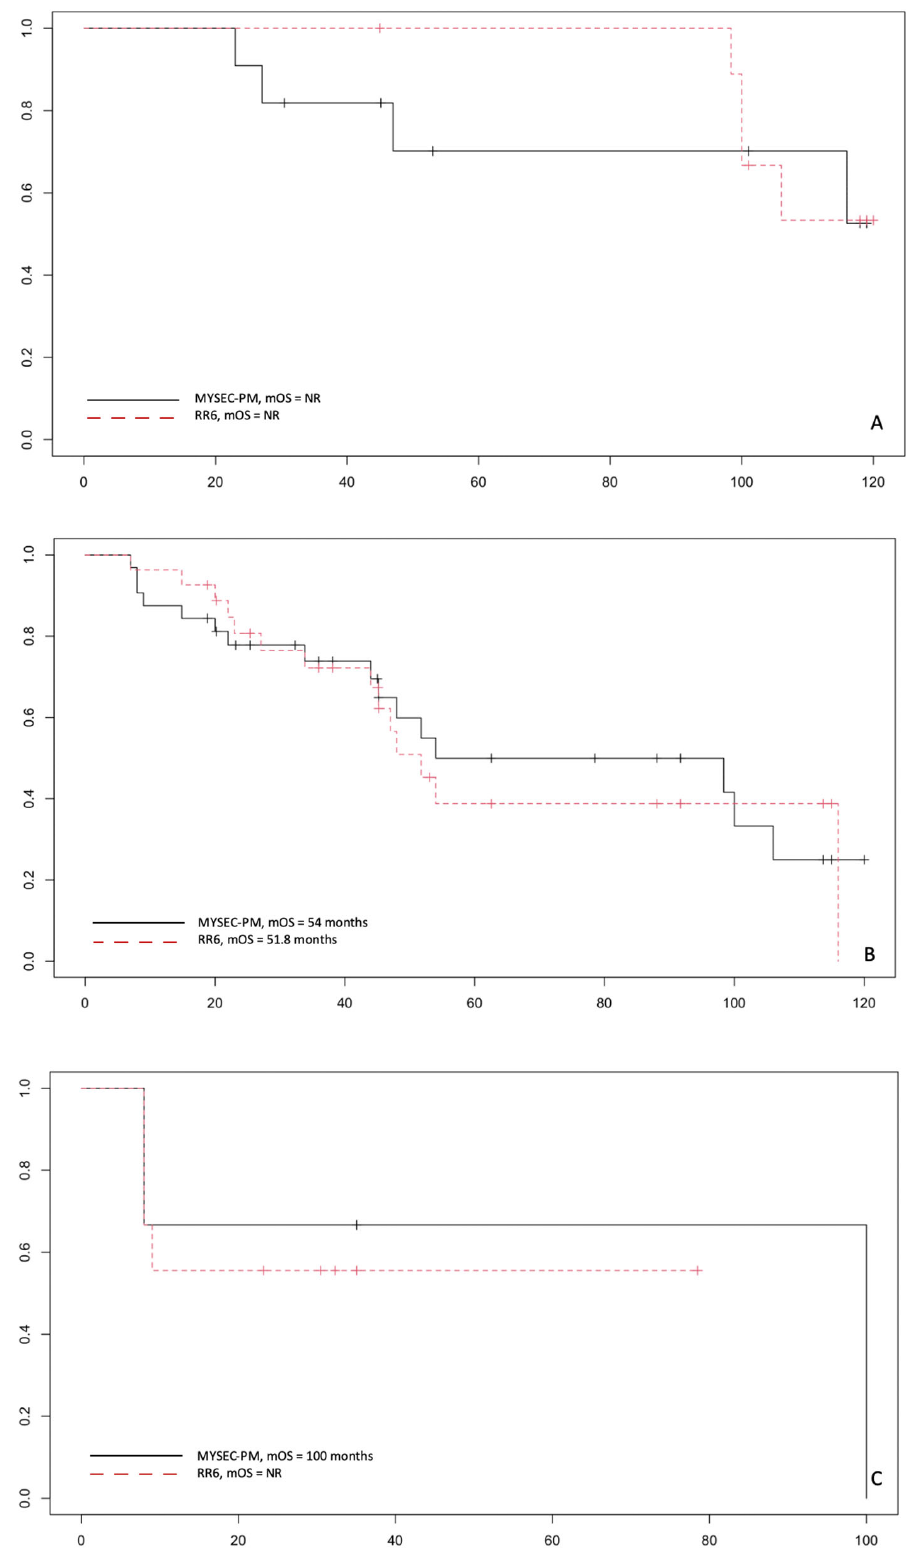
Figure 5. Survival curves in patients with secondary myelofibrosis in risk RR6 low with MYSEC-PM low and Int-1 ( A ); RR6 intermediate with DIPSS Int-2 ( B ); RR6 high with MYSEC-PM high classes ( C ). NR: not reached.